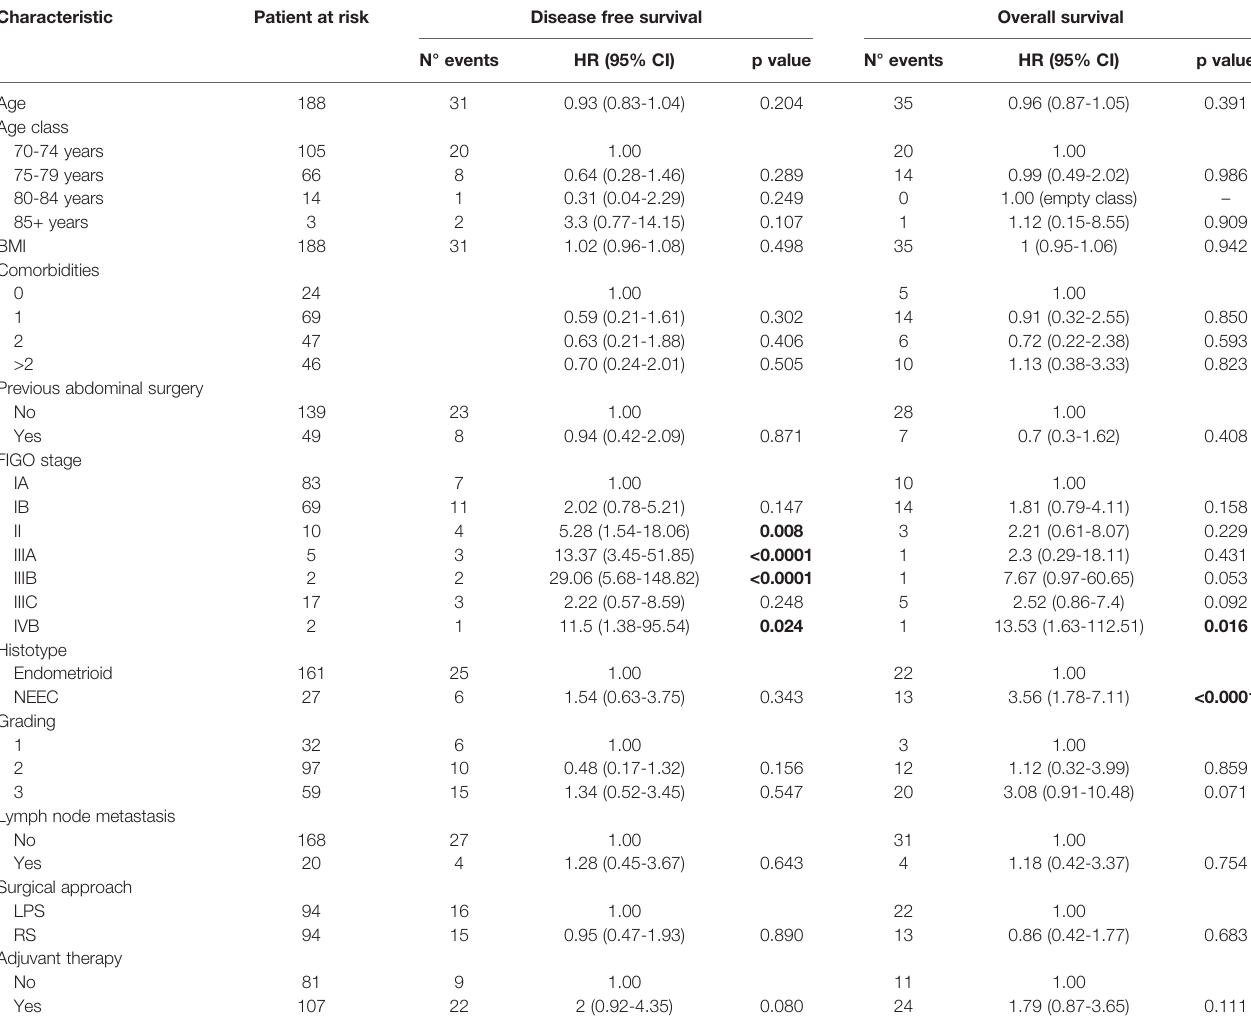
TABLE 5 | Univariable analysis of clinical, pathological and treatment characteristics of 188 matched patients with endometrial cancer according to DFS and OS. Characteristic Patient at